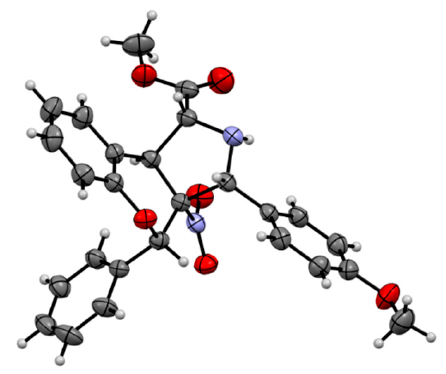
Figure 4. Molecular structure of endo - 8b (ORTEP drawing, 50% probability level).